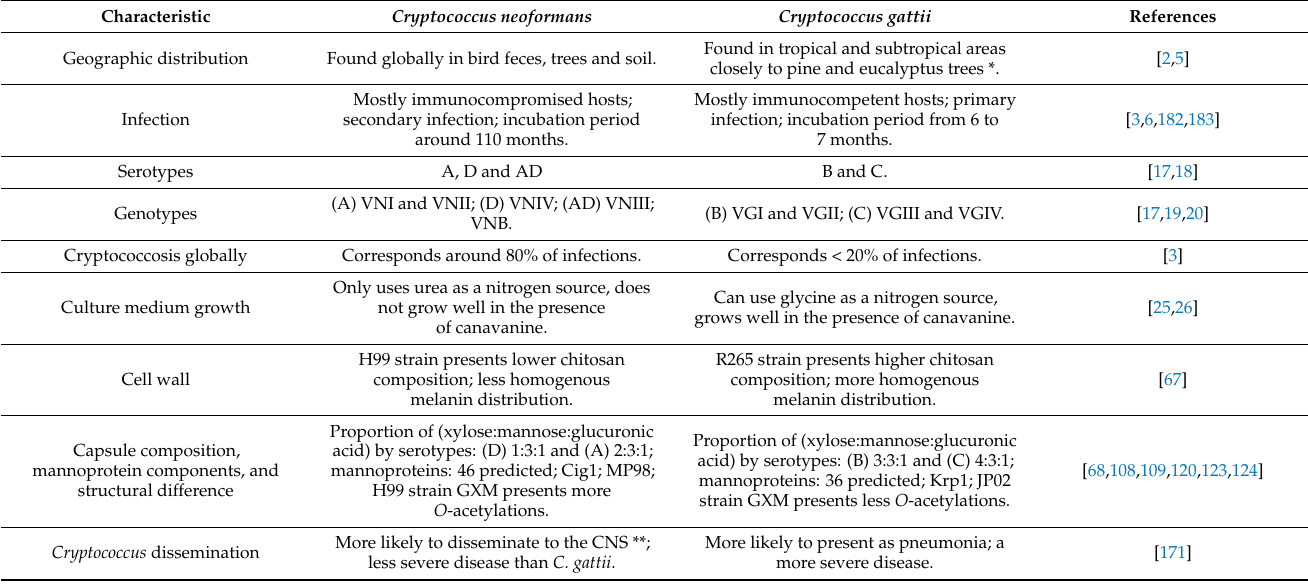
Table 1. Some differences between Cryptococcus pathogenic